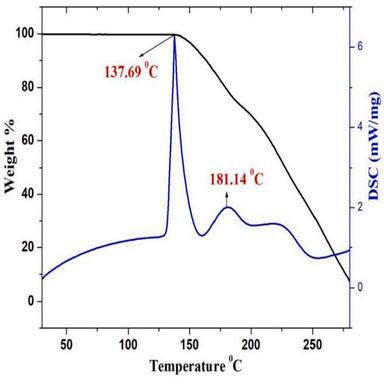
TG/DSC curve for UGA crystal.